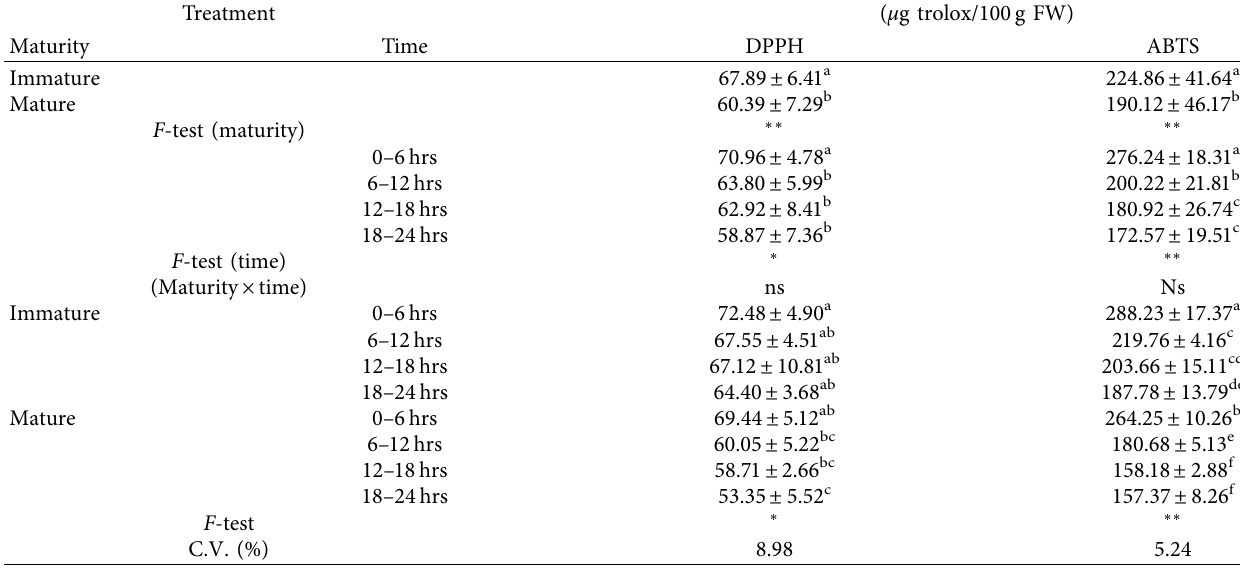
Table 5: Antioxidant capacities of essential oils from immature and mature leaves of B. balsamifera with diferent hydrodistillation periods.